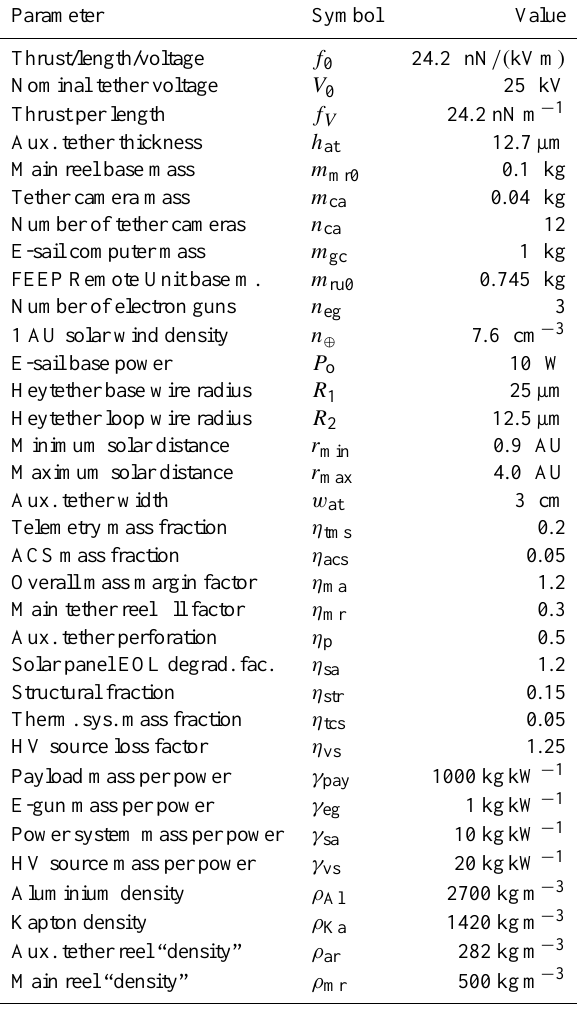
Table 1. Physical reference data. Table 2. Spacecraft mass budget and some other properties for a characteristic acceleration a ⊕ = 0 . 1mms − 2